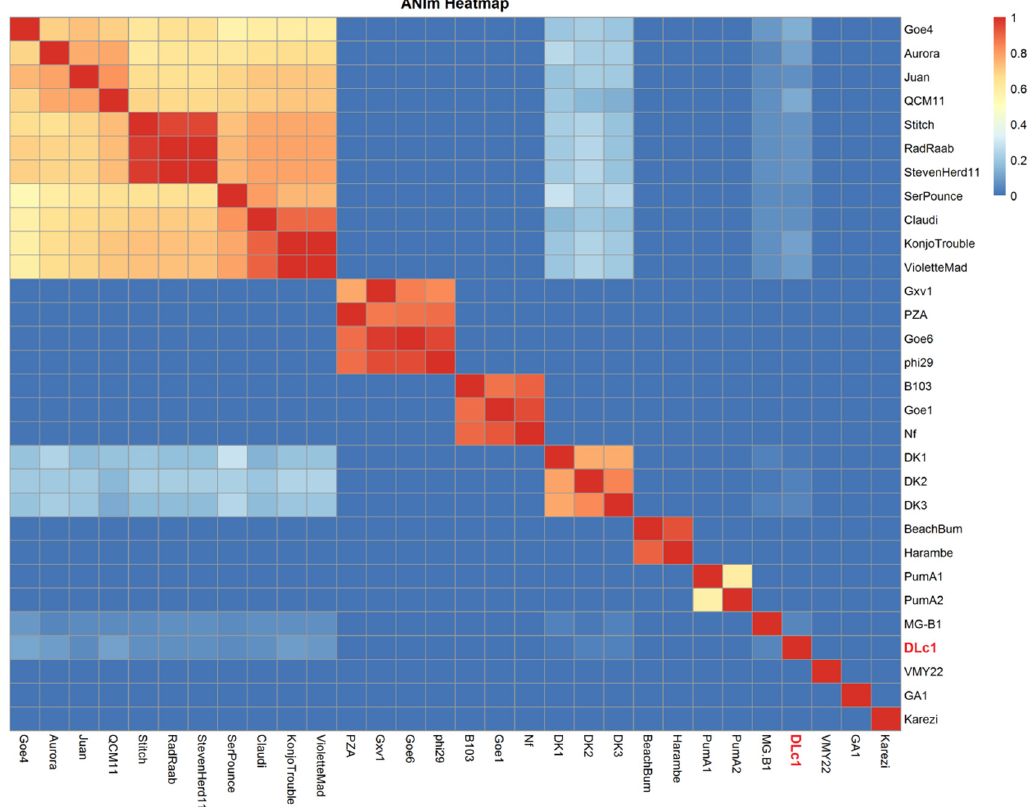
Figure 3. Average nucleotide identity (ANI) analysis of 30 genomes of DLc1 and other ϕ 29-like phages in NCBI. Alignments were performed using the MUMmer (ANIm) method [20] and the Hadamard matrix is presented in a heatmap.